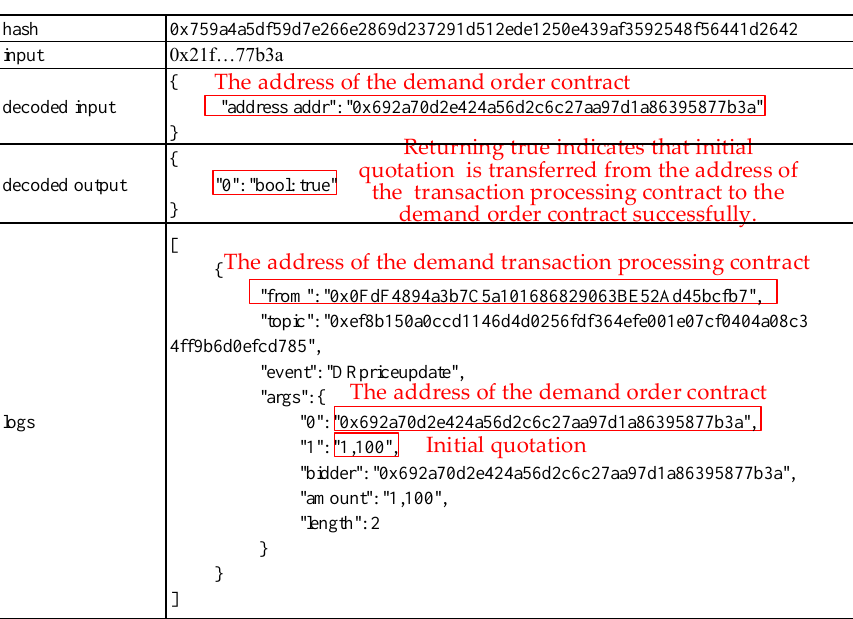
Figure 6. Input of sellers’ parameters .